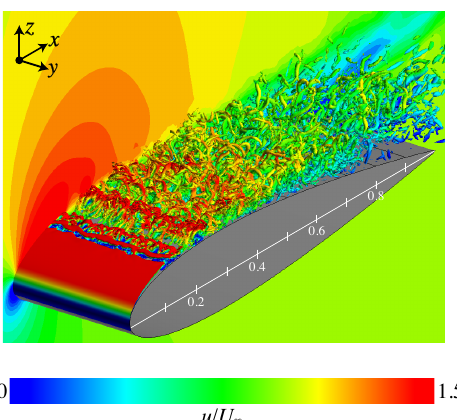
Figure 20. Instantaneous flows with the isosurface of the second invariant of the velocity gradient tensor colored with the chordwise velocity ( u / U ∞ ) in the Burst cases at α = 12.